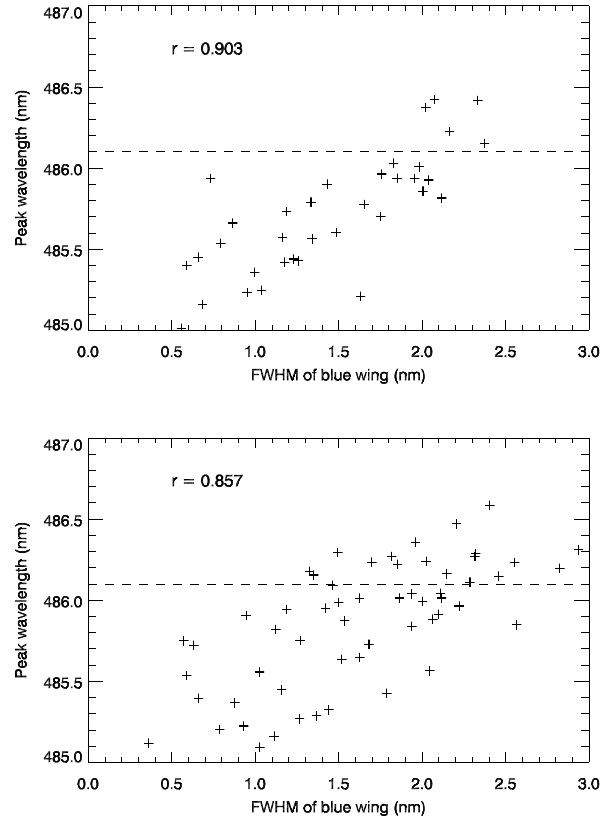
Fig. 6. Dependence of the peak wavelength on the FWHM of blue wing for H- β line observations on 7 February 2000, 8:02:36–11:14:20 UT, (top panel) and on 7 March 2000, 7:12:01– 11:10:46 UT (bottom panel). The correlation coefficients r are in- dicated. The H- β rest wavelength is indicated by the horizontal dashed line in each